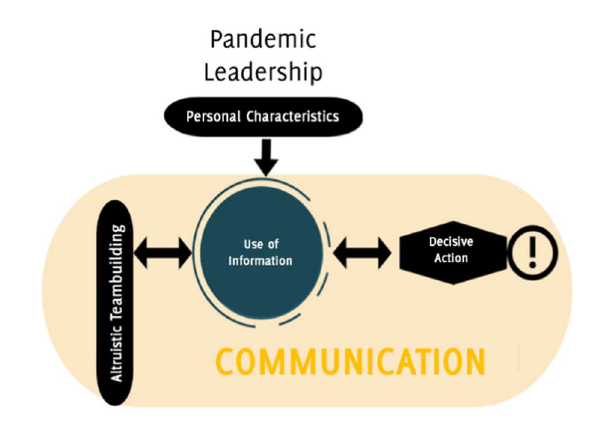
Figure 2 . The Pandemic Leadership Model was Derived from Student Perspectives of Leadership at the University of Michigan Medical School During the COVID-19